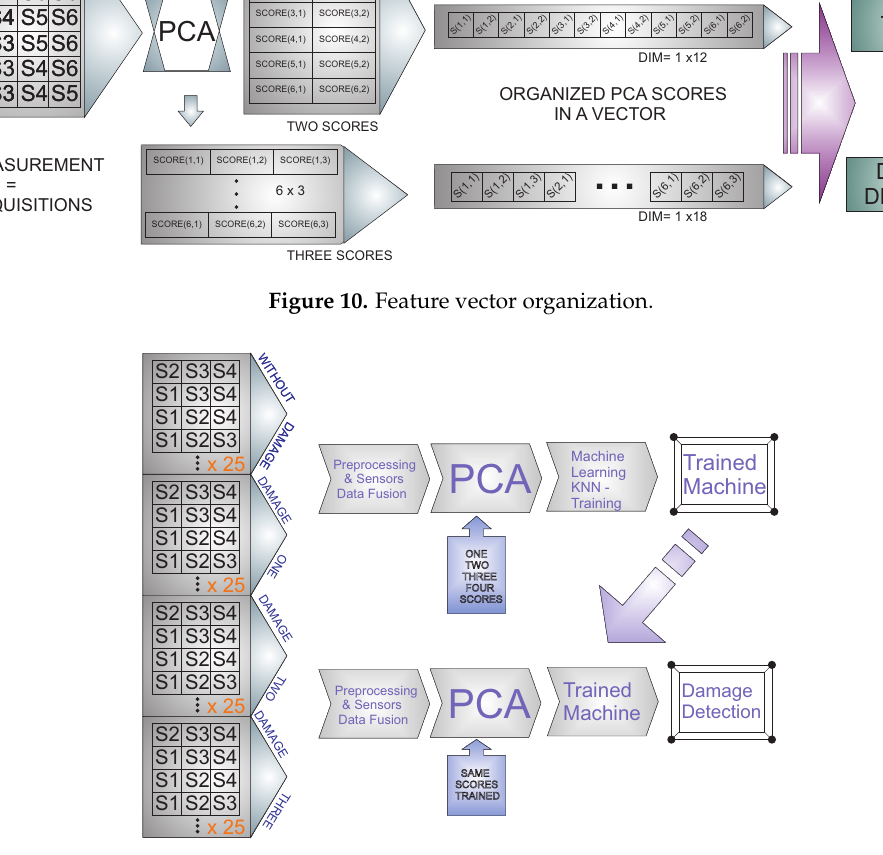
Figure 11. Data organization and testing step for damage detection and